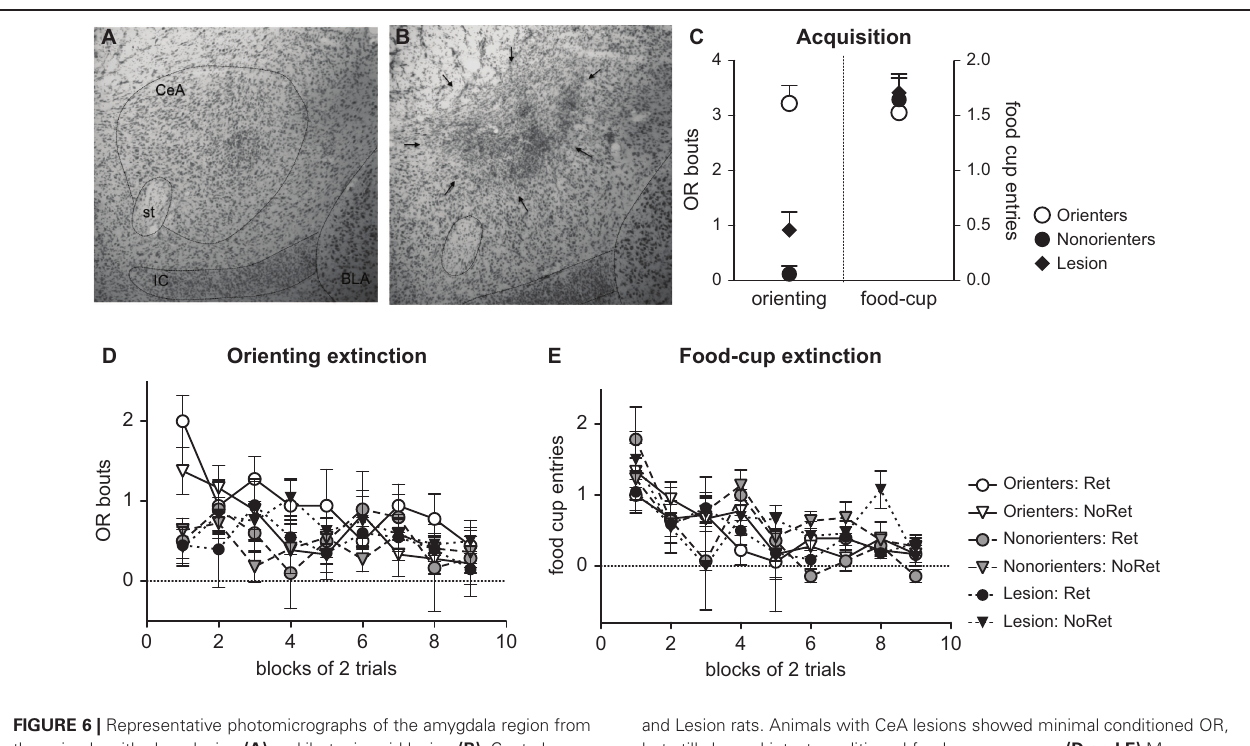
FIGURE 6 | Representative photomicrographs of the amygdala region from the animals with sham lesion (A) and ibotenic acid lesion (B) . Central amygdala (CeA), stria terminalis (ST), intercalated nucleus (IC), and BLA are highlighted. Average lesion size was 65% CeA damage, and rats with significant BLA damage were excluded. (C) Mean ( ± SEM) OR and food cup response during the last eight trials of training for Orienters, Nonorienters,